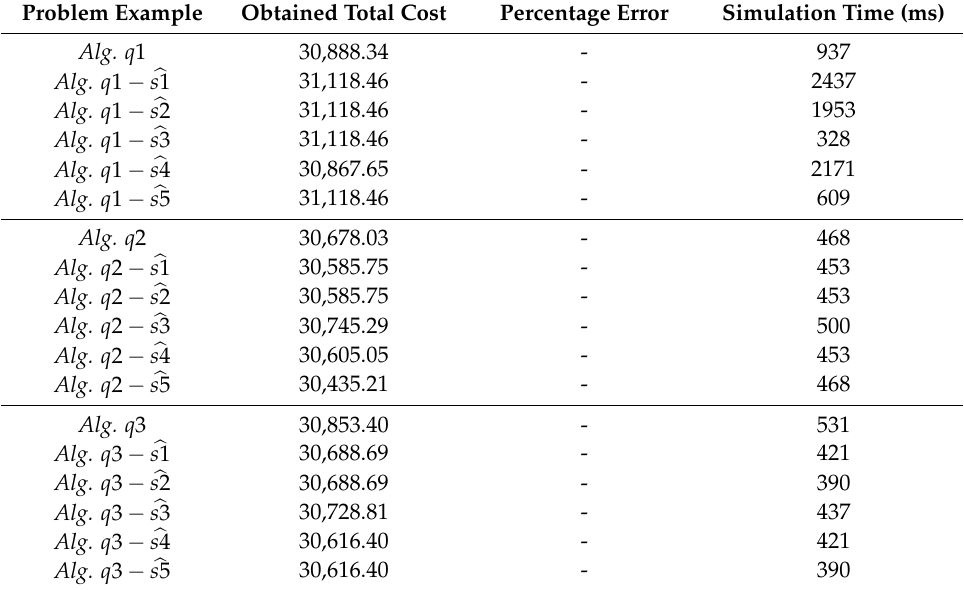
Table 10. Obtained results for irregular network GIr-3 (suboptimal cost).